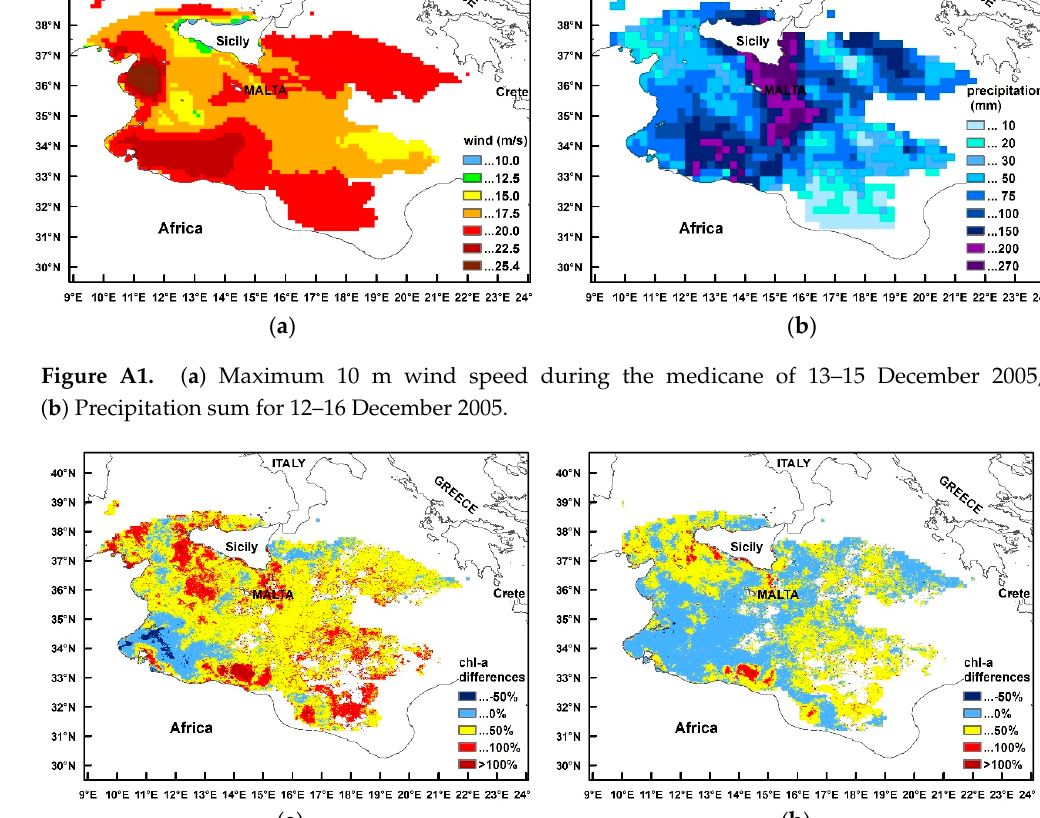
Figure A3. ( a ) Maximum 10 m wind speed during the medicane of 4 December 2008; ( b ) Precipitation sum for 3–5 December 2008.